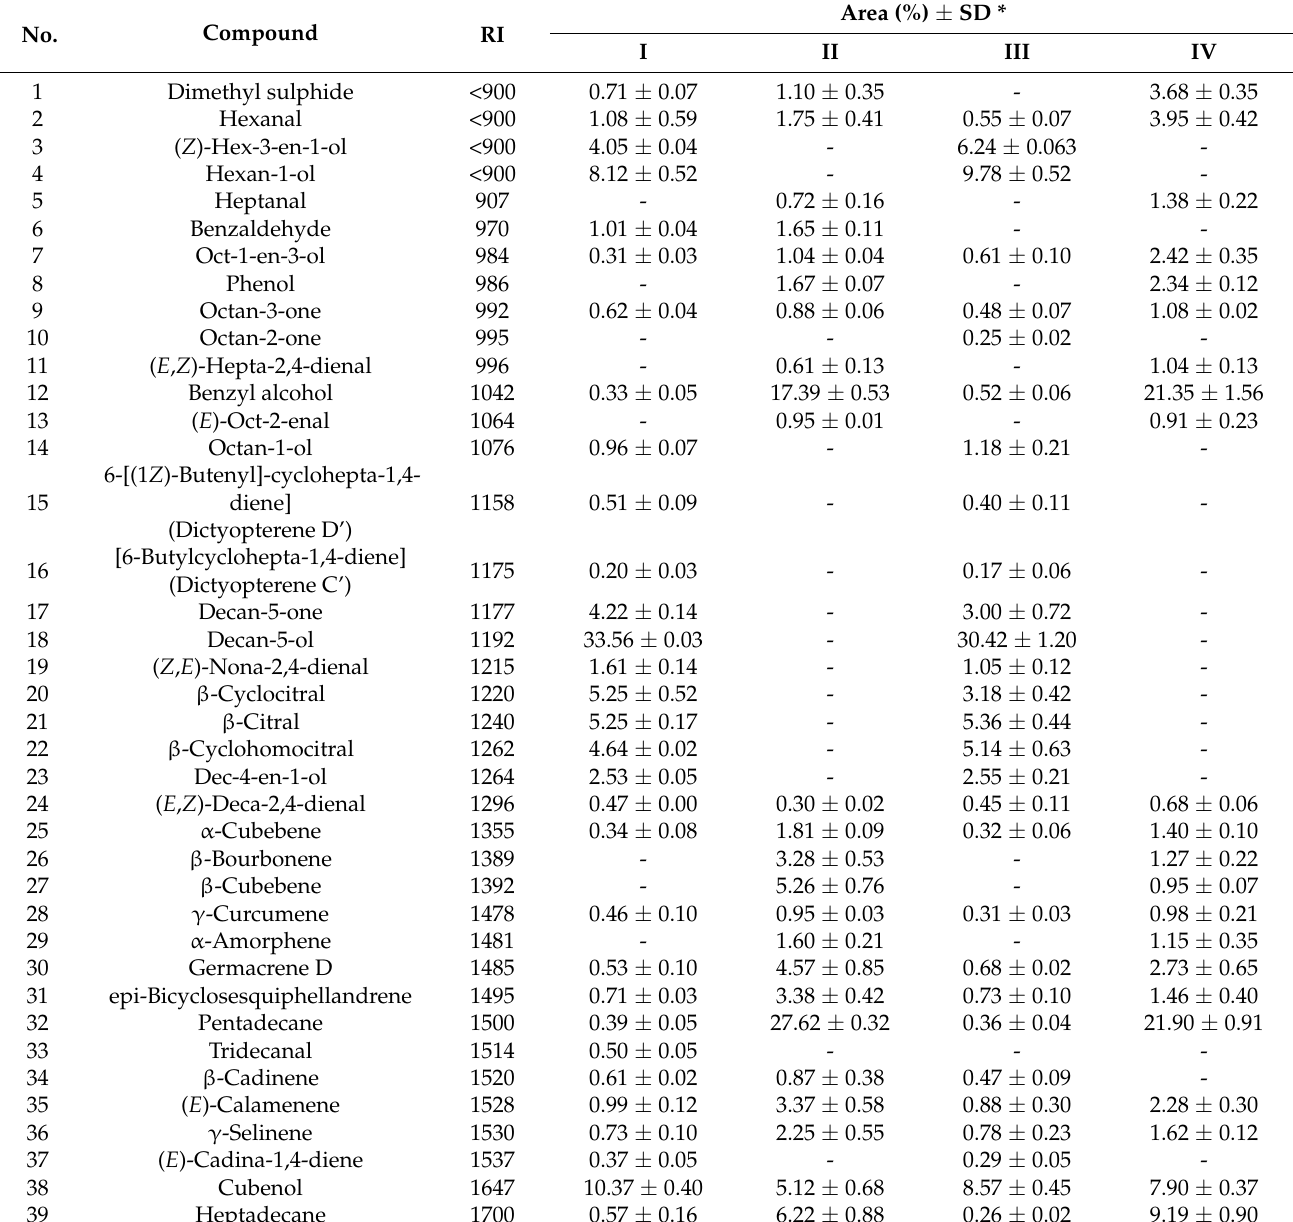
Table 1. The VOCs from C. corniculata that were isolated by HS SPME and analysed by GC–MS: (I—fresh C. corniculata extracted by DVB/CAR/PDMS fibre, II—air-dried C. corniculata extracted by DVB/CAR/PDMS fibre, III—fresh C. corniculata extracted by PDMS/DVB fibre, IV—air-dried C. corniculata extracted by PDMS/DVB